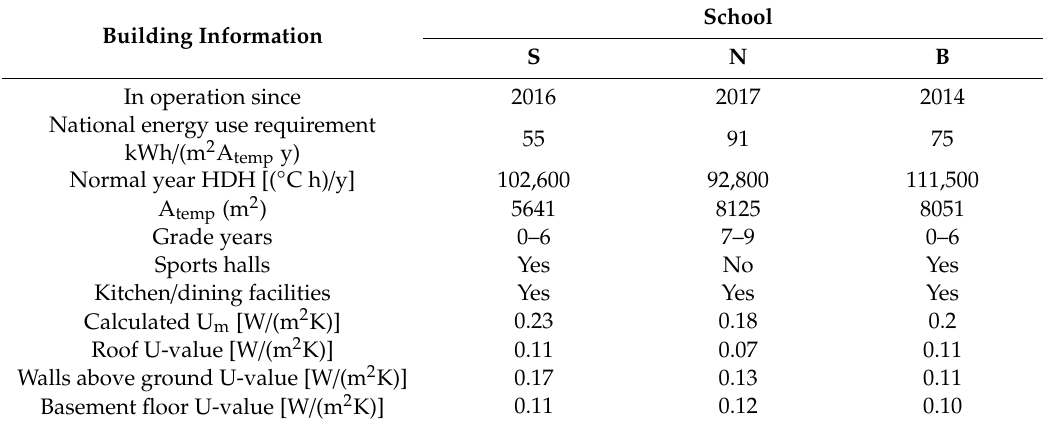
Table 1. Generic building information for the studied